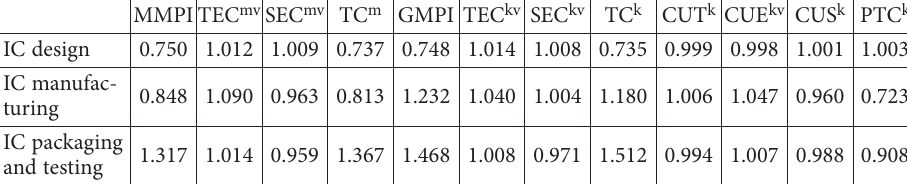
Table 6. The decompositions of GMPI and MMPI from 2009 to